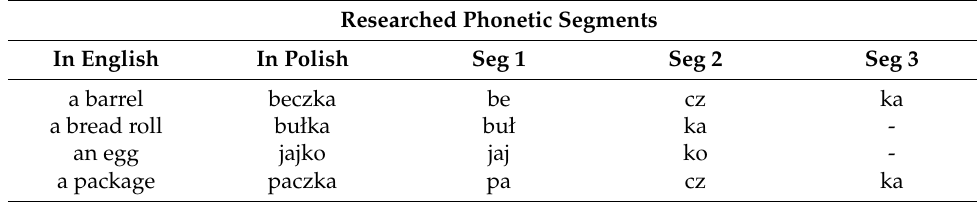
Table 1. The list of the phonetic segments under study.